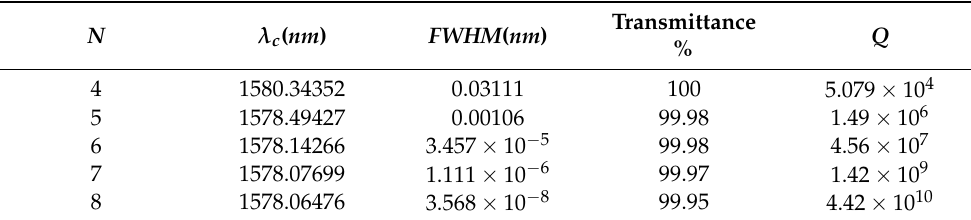
Figure 4. The transmission spectrum of the topological PhC mirror heterostructure for a different number of periods n . Table 1. Q -factor, FWHM, and resonance wavelength of the topological mirror edge state with the number of periods n .